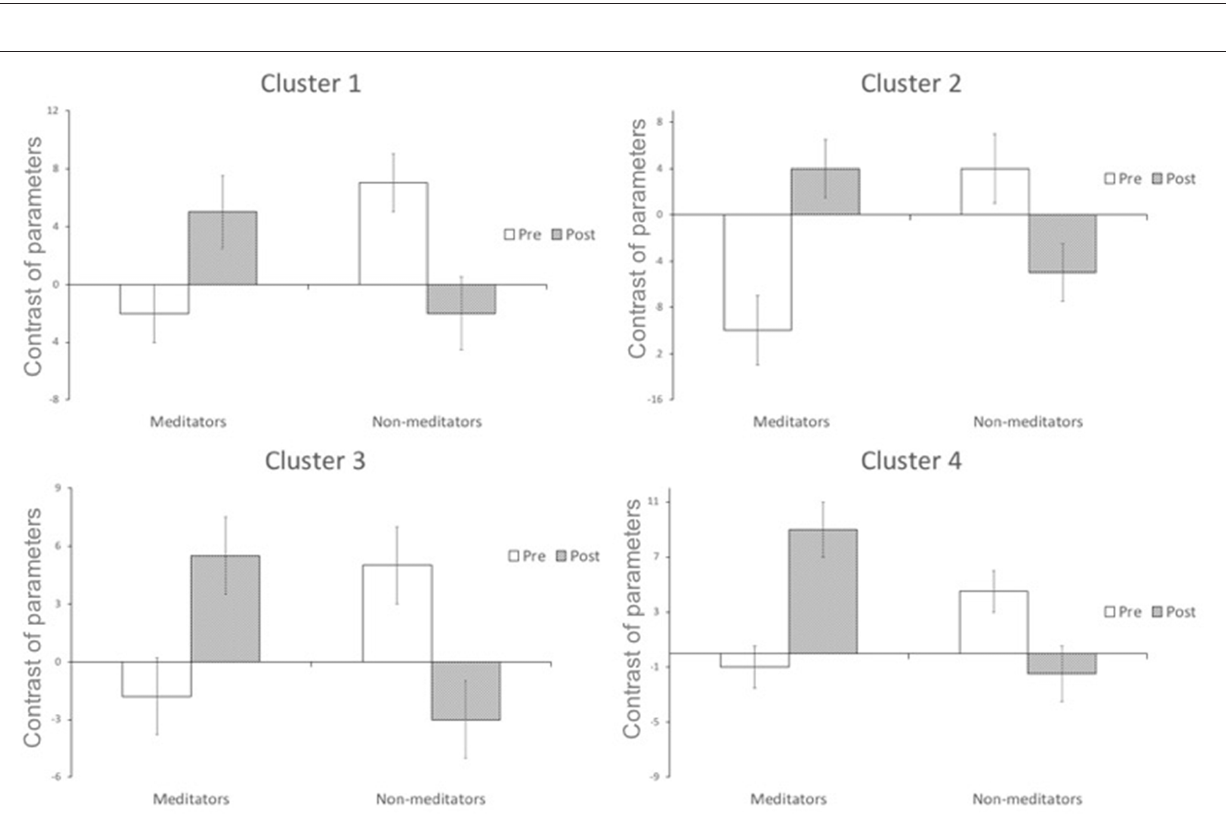
before and after the retreat, clusters encompassing posterior cingulate gyrus, caudate, occipital lobe and frontal pole